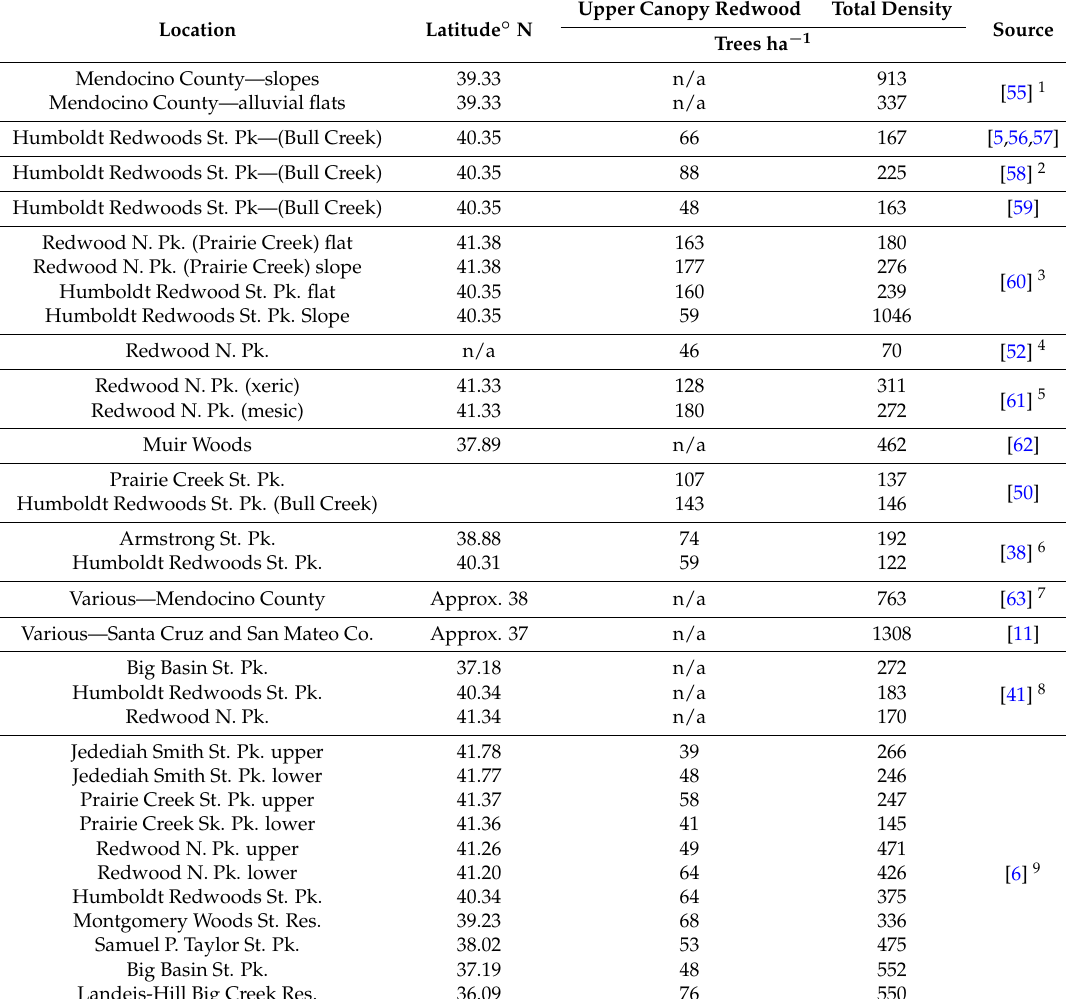
Table 1. Stand density of old redwood forests showing upper canopy redwood trees and total density (adapted from [54]). Studies varied in minimum diameters reported and in definitions of upper canopy